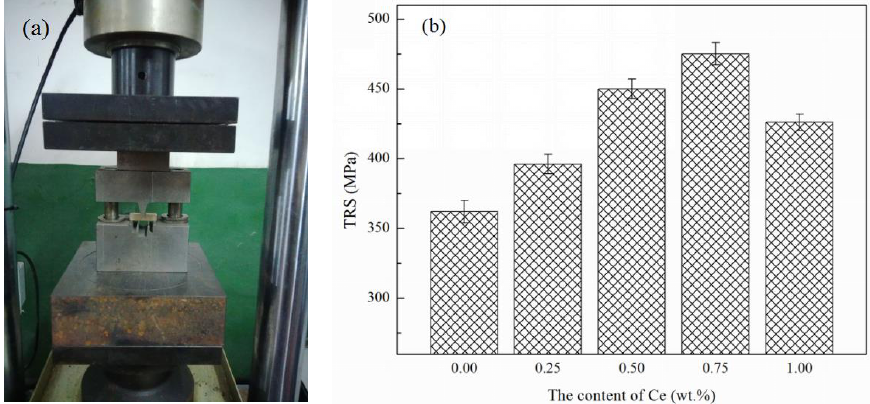
Figure 5. Test device of the transverse rupture strength (TRS) ( a ) and the influence of Ce content on TRS ( b ).